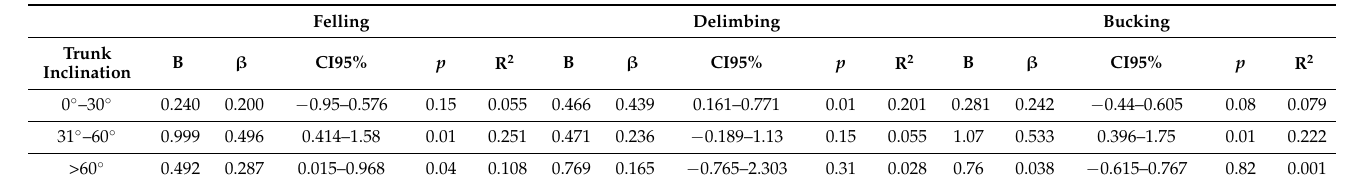
Table 8. Linear regression model: trunk inclination classifications as predictive variables associated with %CVL in the total sample ( n = 40) for the three tasks of felling, delimbing, and bucking. Felling Delimbing